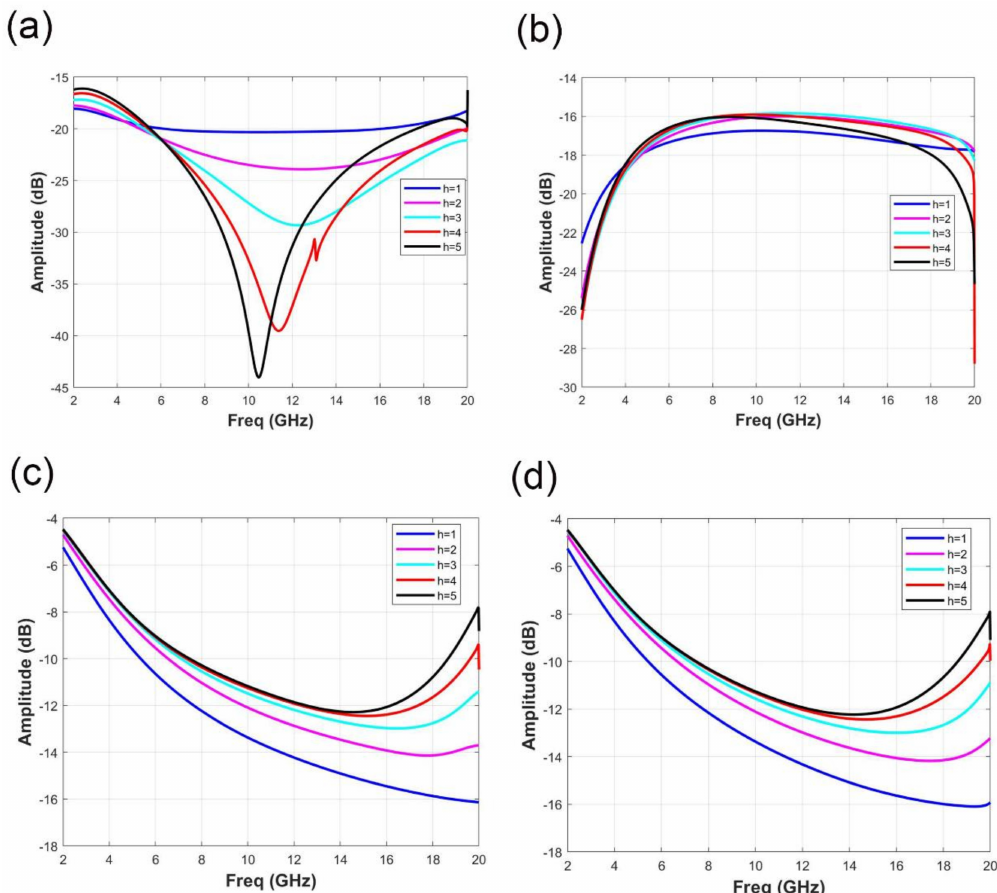
Figure 3. Variation of reflection coe ffi cient S11 and transmission coe ffi cient S21 under di ff erent polarization modes when h changes. ( a ) Under x polarization, the reflection coe ffi cient S11 changes with h. ( b ) Under y polarization, the reflection coe ffi cient S11 changes with h. ( c ) Under x polarization, the transmission coe ffi cient S21 changes with h. ( d ) Under y polarization, the transmission coe ffi cient S21 changes with